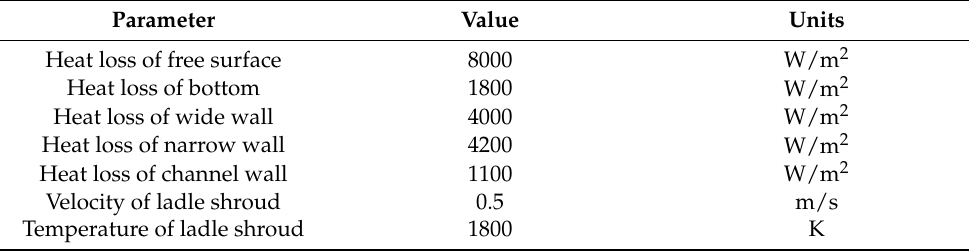
Table 3. Heat losses of wall, velocity and temperature of inlet from the